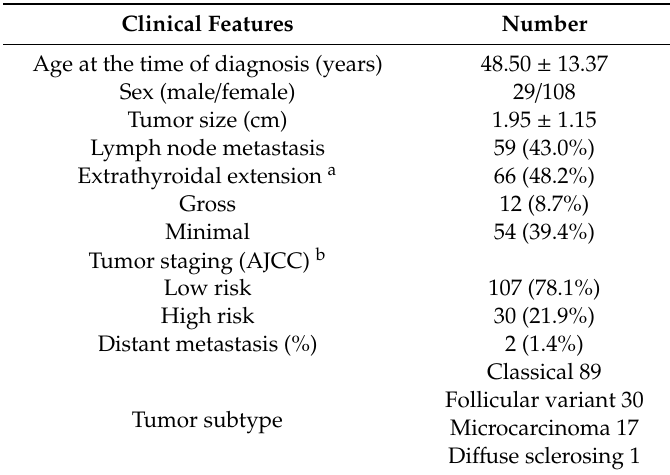
Figure 1. Quantitative reverse transcription–polymerase chain reaction (qRT-PCR) analysis of ( A ) AR , ER α , ER β , and PR in PTCs ( n = 71) and paired normal tissue. The fold change values indicate the relative change in the expression levels between samples and its internal control ( 18S ), assuming that the value of 18S expression level of each sample was equal to 1. ( B ) Relative expression of AR mRNA levels in PTC normalized to adjacent non-tumor tissues (T/N fold change). AR mRNA expression indicated a significant reduction compared to matched normal tissue. Fold change in AR mRNA expression was calculated relative to paired normal thyroid tissue. *** p < 0.001 * p < 0.05. Table 1. Clinicopathological features of papillary thyroid carcinomas in this study ( n =